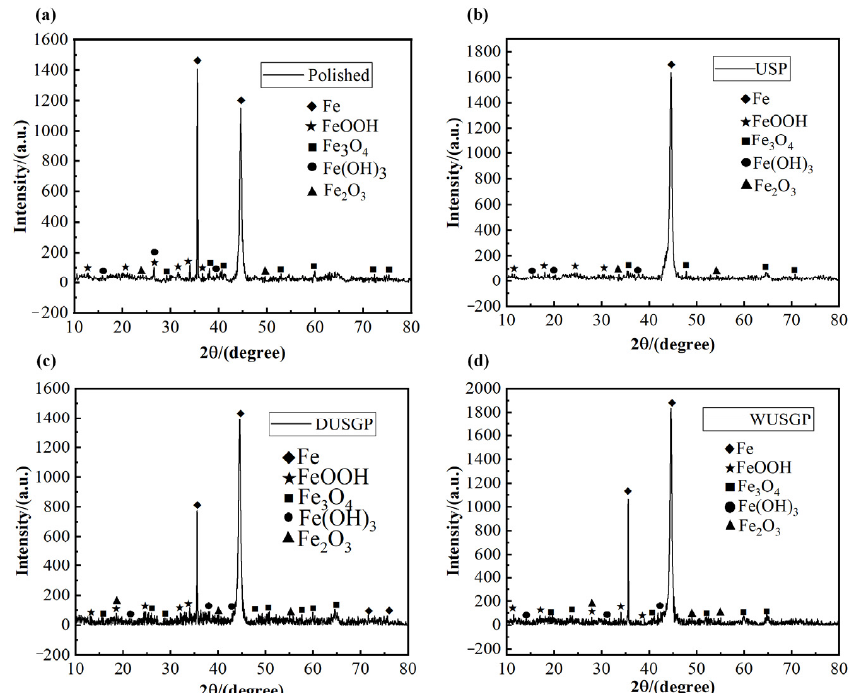
Figure 7. XRD patterns of corrosion products for each sample: ( a ) the corrosion macro ‐ morphology of Sample polished; ( b ) the corrosion macro ‐ morphology of Sample USP; ( c ) the corrosion macro ‐ morphology of Sample DUSGP; ( d ) the corrosion macro ‐ morphology of Sample WUSGP.